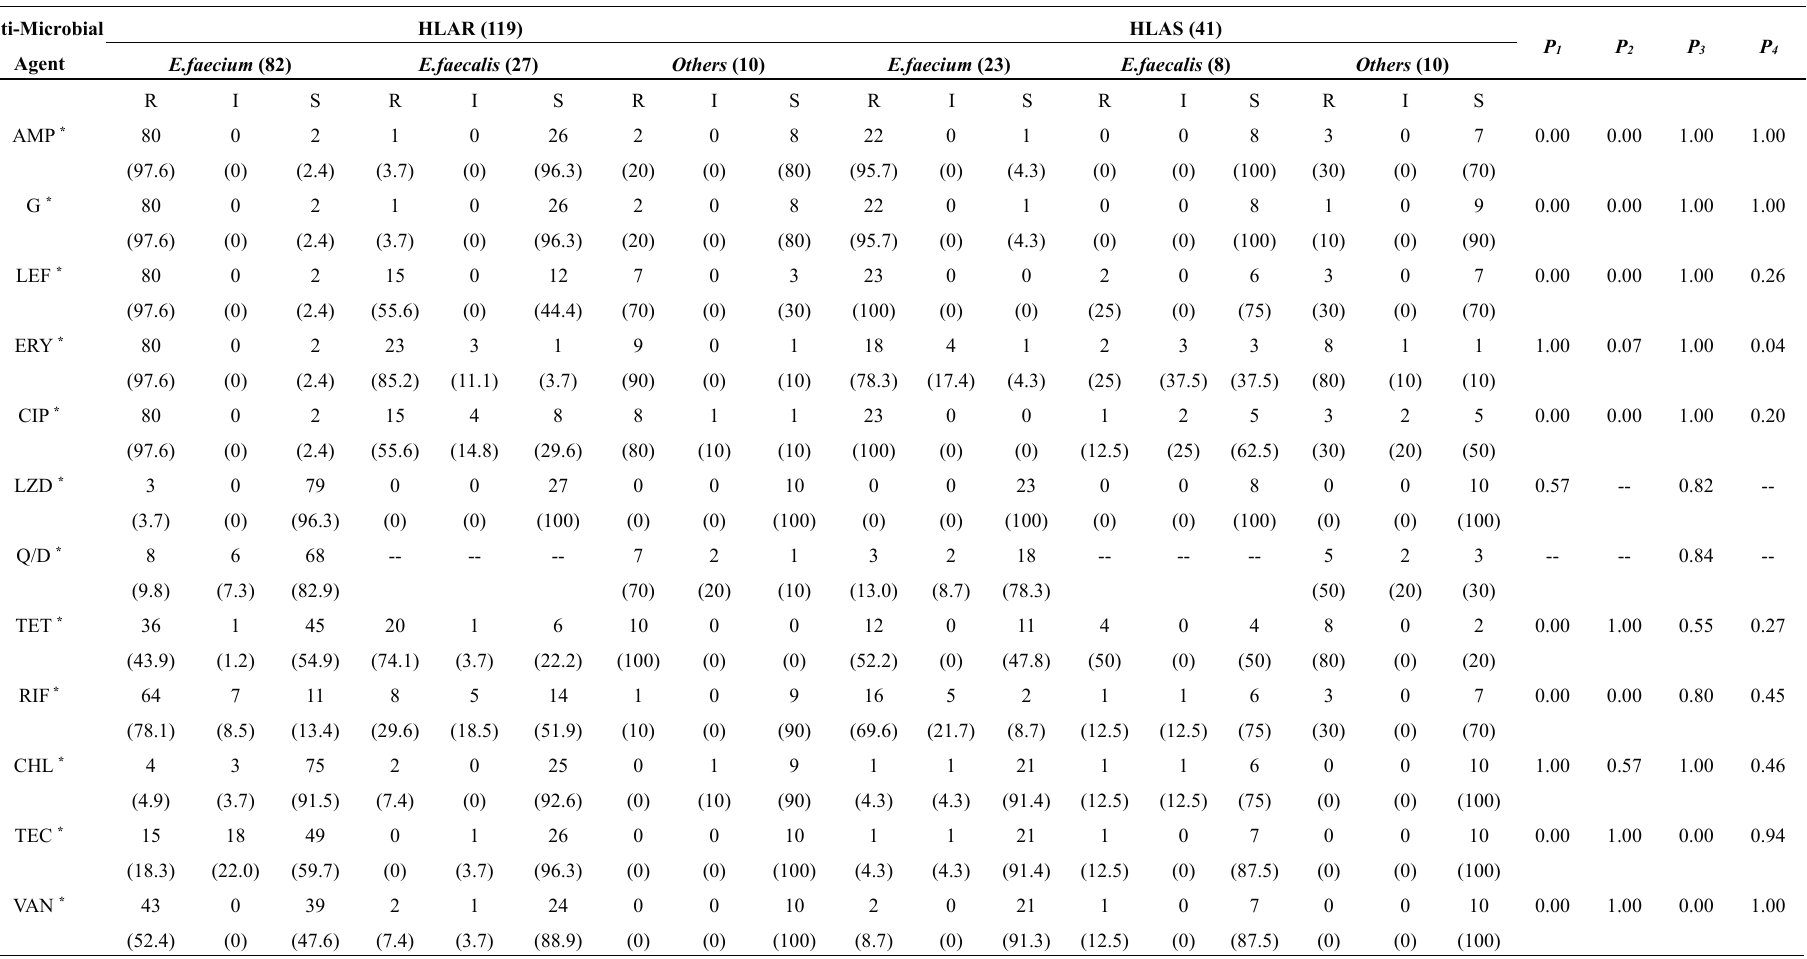
Table 2. Antibiotic susceptibility profiles of the tested Enterococcus